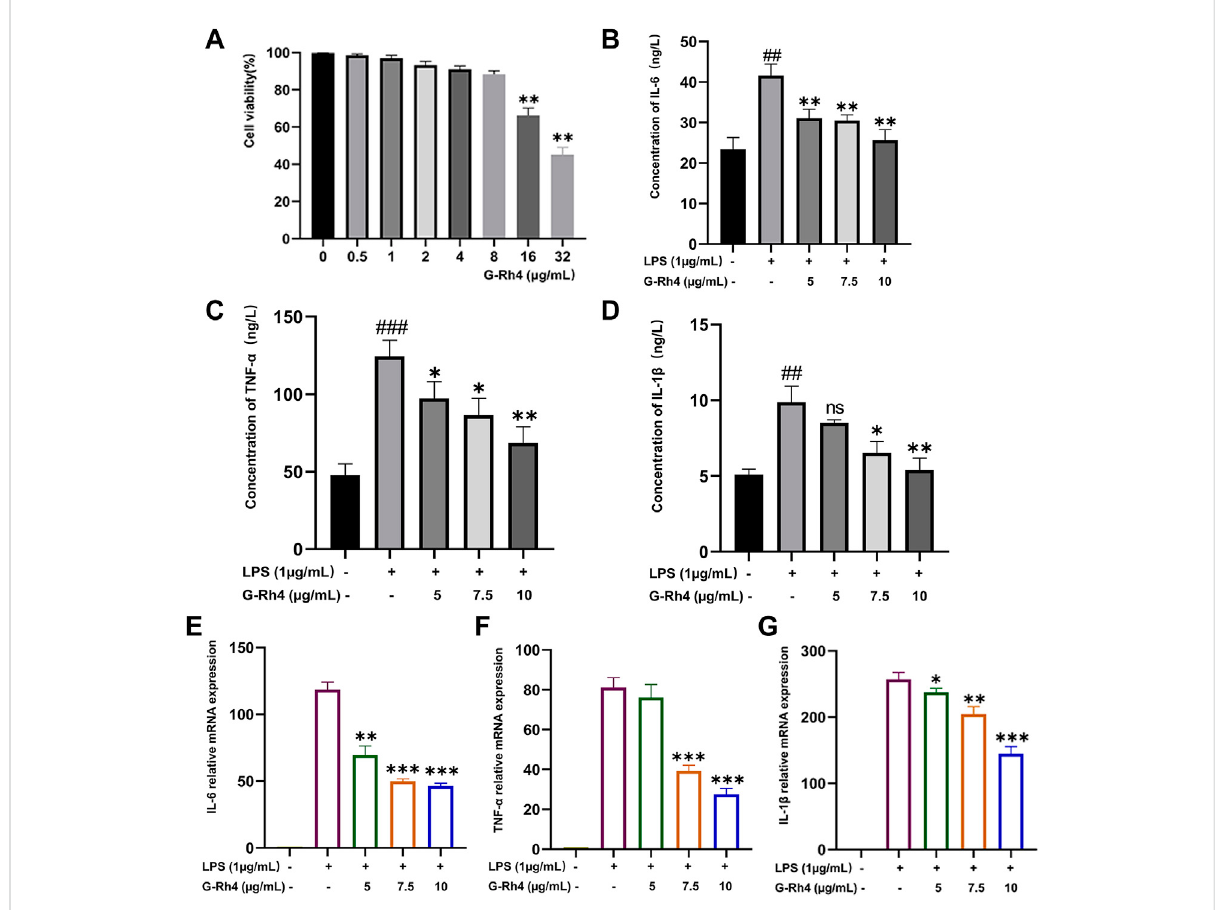
FIGURE 4 Effect of G-Rh4 on RAW264.7 cells. (A) Effect of G-Rh4 on cell viability. Cells were treated with different concentrations of G-Rh4 for 24 h. (B – D) Production of IL-6, TNF- α , and IL-1 β in LPS-stimulated RAW264.7 cells was determined by ELISAs. (E – G) Effect of G-Rh4 on TNF- α , IL-6, and IL-1 β mRNA levels in RAW264.7 cells. Data were presented as the mean ± SD values performed in triplicate ( ## p < 0.01 and ### p < 0.001 vs. control group, * p < 0.05, ** p < 0.01, *** p < 0.001 vs. LPS group).